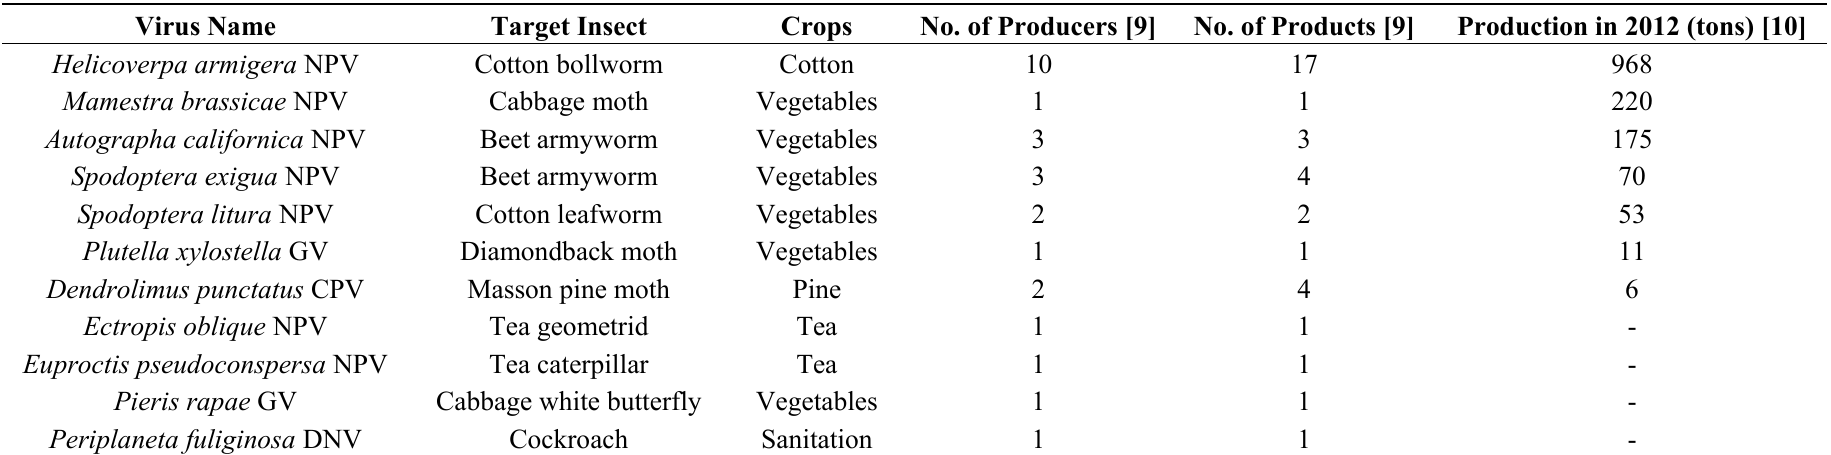
Table 2. Viruses authorized by the Ministry of Agriculture of China as commercial